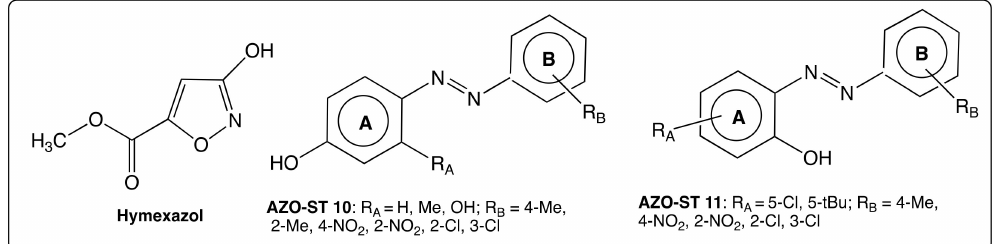
Figure 12. Structure of hymexazol and structure of compounds of the AZO-ST series 10 and AZO-ST series 11